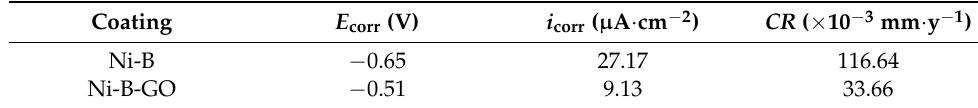
Figure 9. PDP curves of the substrate, Ni − B coating, and Ni − B − GO coating. Table 2. Tafel curve analysis for Ni-B and Ni-B-GO